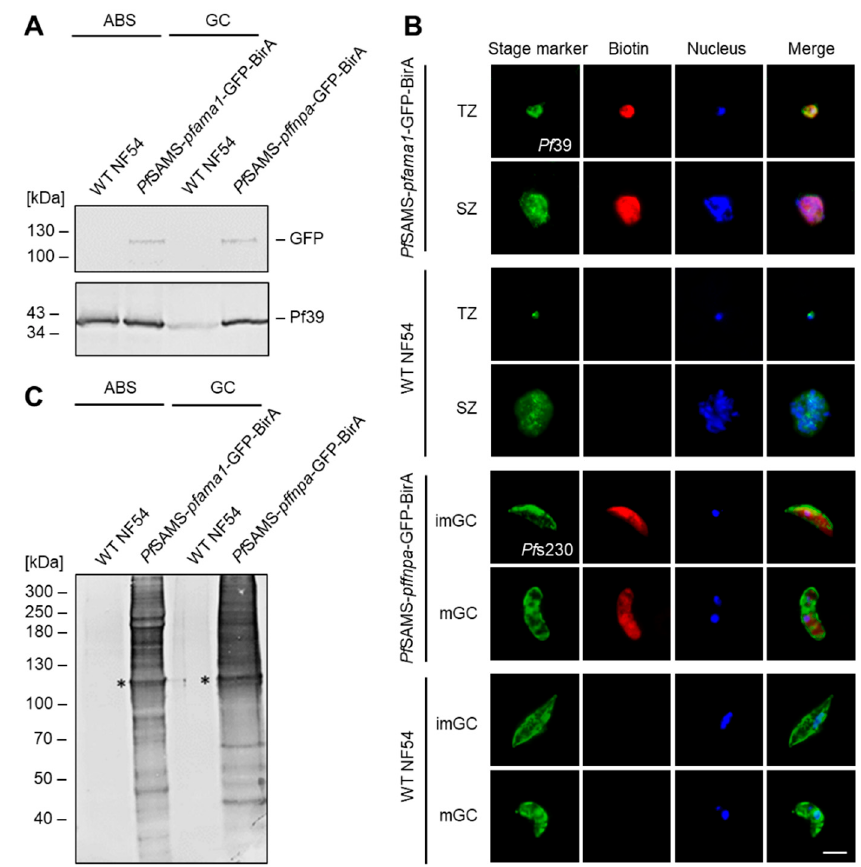
Figure 4. Generation and verification of Pf SAMS-GFP-BirA parasite lines. ( A ) Verification of Pf SAMS expression. Lysates of asexual blood stages (ABS) of the Pf SAMS- pfama1 -GFP-BirA and gametocytes (GC) of the Pf SAMS- pffnpa -GFP BirA lines were subjected to Western blotting to detect Pf SAMS-GFP-BirA (108 kDa), using mouse anti-GFP antibody. Immunoblotting with rabbit antisera directed against Pf 39 (39 kDa) served as a loading control. WT NF54 lysates were used as negative controls. ( B ) Localization of biotinylated proteins in the Pf SAMS-GFP-BirA blood stages. Asexual blood stages of the Pf SAMS- pfama1 -GFP-BirA line and gametocytes of the Pf SAMS- pffnpa -GFP-BirA line were treated with 50 µM biotin for 24 h. WT NF54 was used as a negative control. Immunofluorescence assays were employed, using mouse antibodies directed against Pf 39 to highlight trophozoites (TZ), and schizonts (SZ) and rabbit antisera directed against Pf s230 to highlight immature (imGC) and mature (mGC) gametocytes (green). Biotinylated proteins were immunolabeled using fluorophore-conjugated streptavidin (red). The nuclei were labeled with Hoechst 33342 nuclear stain (blue). Bar; 5 µm. ( C ) Detection of biotinylated proteins in the Pf SAMS-GFP-BirA lines. Lysates of asexual blood stages (ABS) from the Pf SAMS- pfama1 -GFP-BirA line and gametocytes (GC) of the Pf SAMS- pffnpa -GFP-BirA line were produced following treatment of the cultures with 50 µM biotin for 24 h. Streptavidin coupled to alkaline phosphatase was used for immunoblotting. Asterisks indicate the expected band for Pf SAMS-GFP-BirA (~108 kDa). The results are representative of two ( A , C ) or three ( B ) independent experiments. Subsequent immunolabeling experiments using fluorophore-conjugated streptavidin unveiled the presence of biotinylated proteins in the cytoplasm and nuclear regions of